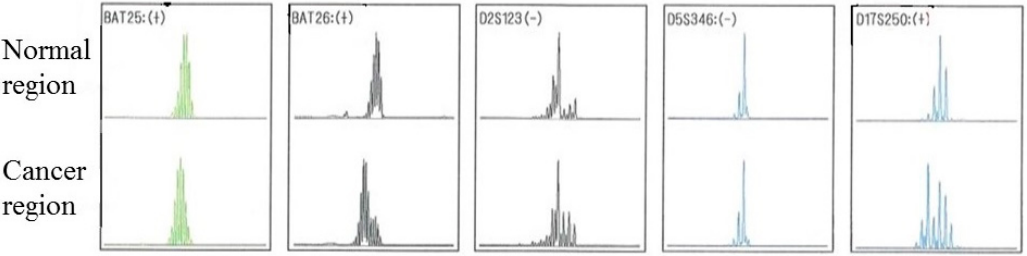
Figure 5. Checking microsatellite instability (MSI) with five satellite markers, as recommended by National Cancer Institute (NCI). BAT25, BAT26, and D17S250 were positive, showing high level MSI (MSI ‐ H).